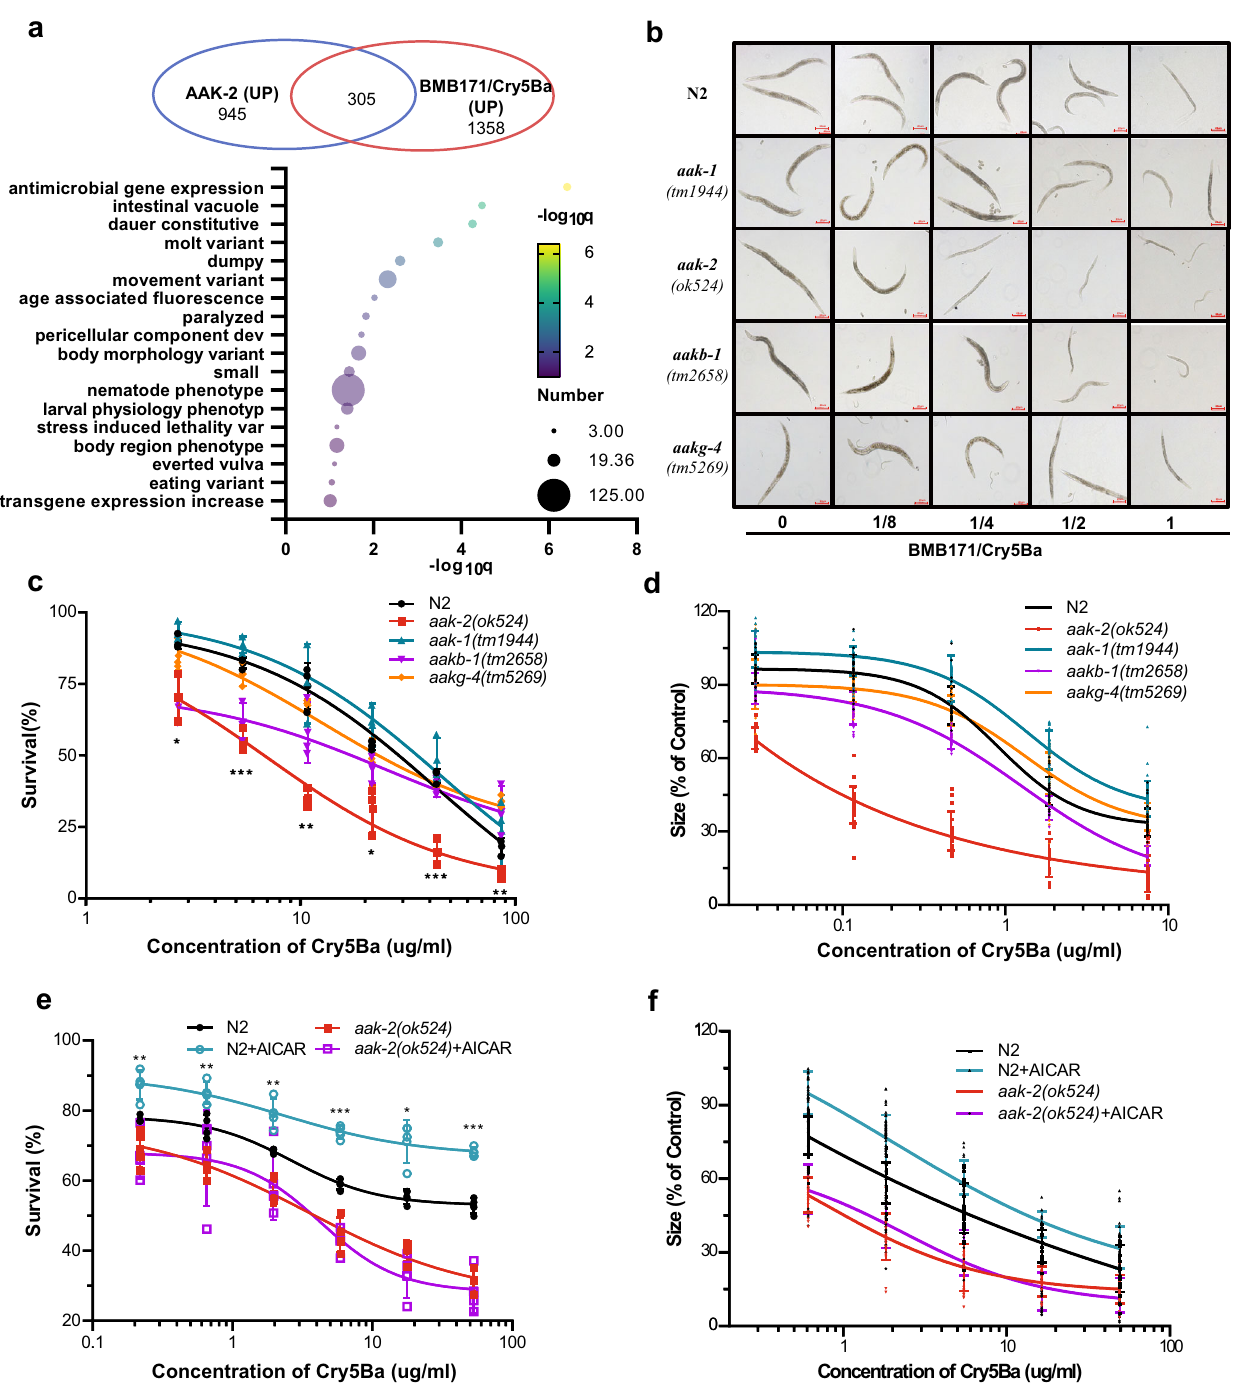
Fig. 5 The AMPK activation is involved in C. elegans defense against Bt infection. a Venn diagram comparing the overlaps between genes activated by nematicidal Bt and the target genes of AAK-2 in C. elegans . The Phenotype Enrichment Analysis according to Wormbase database was used to identify gene function. b The growth assay of the wild-type N2 and mutant worms after BMB171/Cry5Ba infection. The “ 0, 1/8, ¼, ½, and 1 ” represent the different concentrations of BMB171/Cry5Ba, up to 7.4 μ g/ml Cry5Ba, as shown in ( d ). Representative worms are shown for each dose. Scale bar represents 200 μ m. N = 3 independent experiments. c Survival of wild-type N2 and mutant worms after BMB171/Cry5Ba infection. d Quanti fi cation of worm growth. To quantify growth, worms were photographed under ×100 magni fi cation for each dose, and the average worm areas were calculated. The size of the worms in the absence of toxin was set at 100%. The survival assay ( e ) and the growth assay ( f ) of the wild-type worms N2 and mutant worms aak-2 ( ok524 ) after BMB171/Cry5Ba infection when the AMPK was activated by AICAR or not. N = 3 independent experiments contain three replication of at least 30 worms in ( c ) and ( e ), N = 3 independent experiments containing at least 30 worms in ( d ) and ( f ). Data points represent the mean values of three independent replicates, error bars denote the SD in ( c – f ). The p -value was determined by a Student ’ s t -test (Welch ’ s correction for unequal variances), *** p < 0.001, ** p < 0.01, * p < 0.05 and ns indicate no signi fi cant